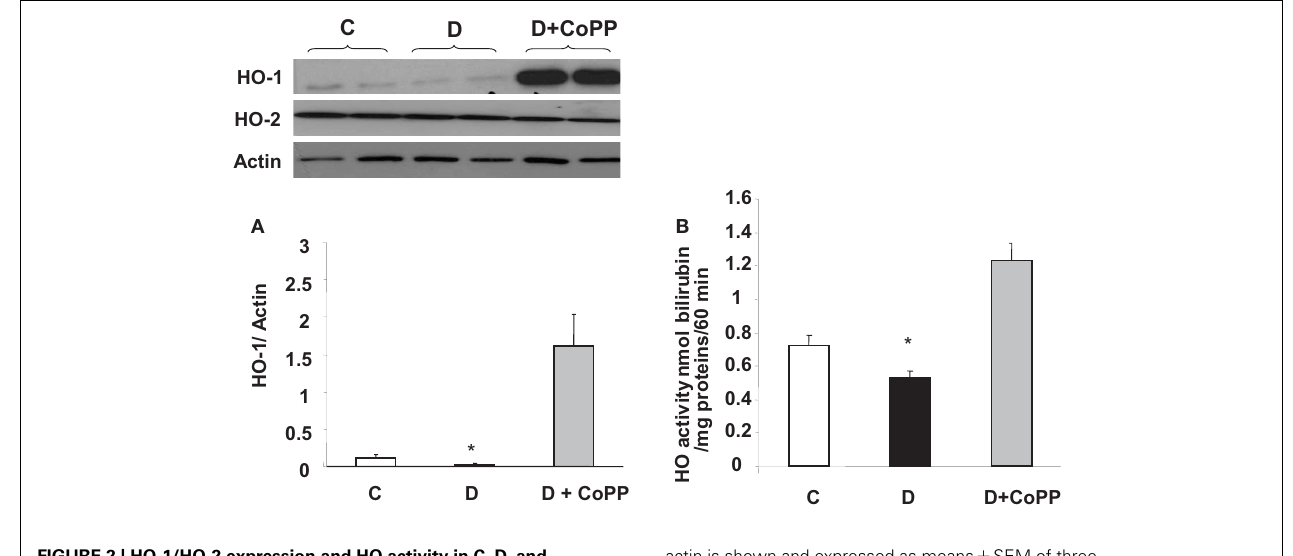
FIGURE 2 | HO-1/HO-2 expression and HO activity in C, D, and D + CoPP rat hearts. Heart samples were subjected toWestern blotting for the determination of HO-1/HO-2 protein. A representative blot is shown. Densitometric analysis of HO-1 vs.